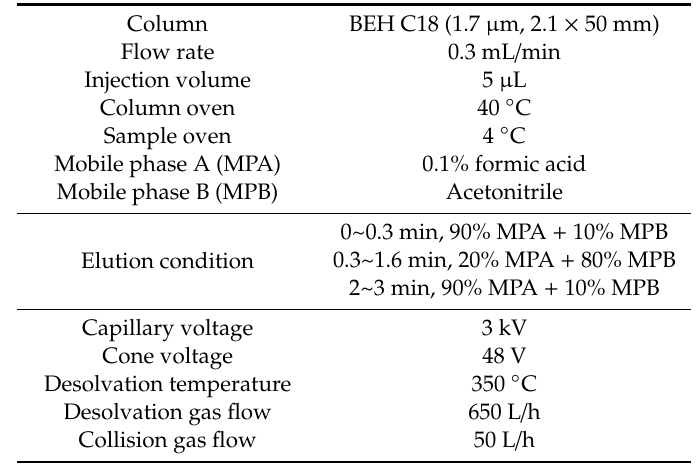
Table 2. Optimized multiple reaction monitoring parameters for nilotinib and imatinib.